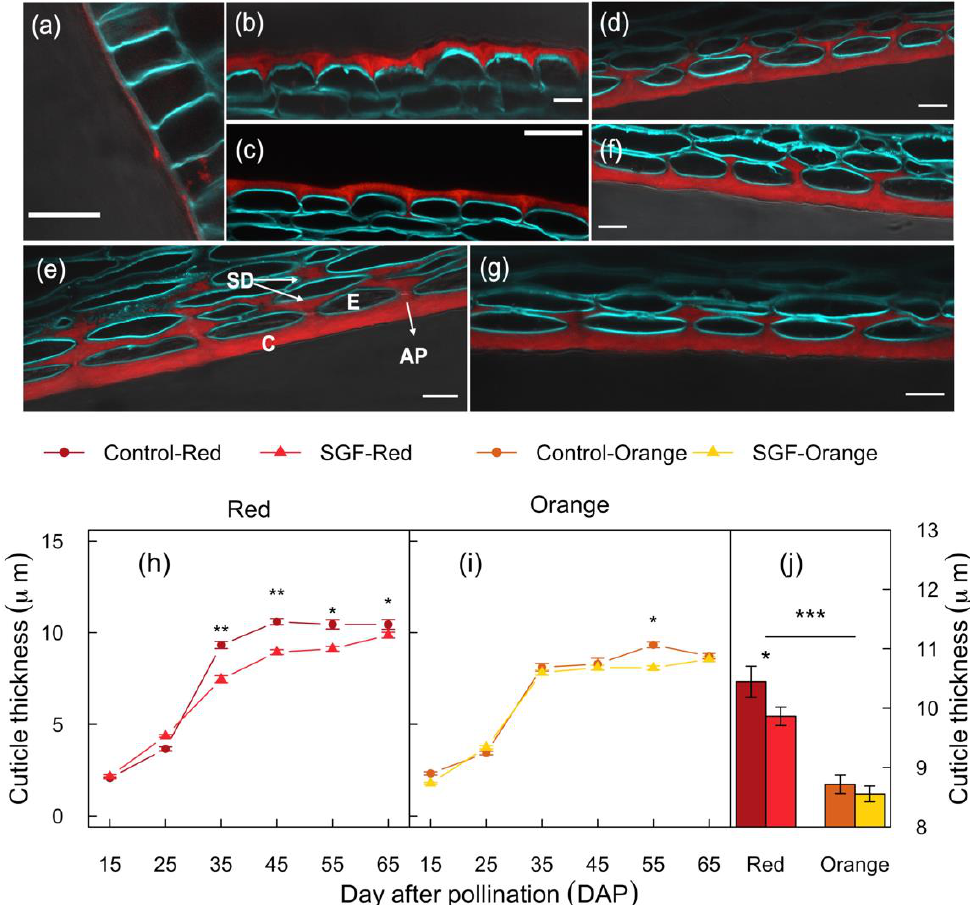
Figure 2. SGF impacts cuticle deposition during fruit development in a cultivar specific manner. ( a – g ) Confocal image panels showing the cuticle layer from the Red cultivar at 7 ( a ), 15 ( b ), 25 ( c ), 35 ( d ), 45 ( e ), 55 ( f ), and 65 ( g ) DAP. The lipophilic fluorescent dye Nile Red was used to stain the cuticle layer (red) and Calcofluor White M2R dye was used to stain cellulose in the cell walls (blue). Scale bar = 20 μm. ( h – i ) Cuticle thickness of fruits was quantified at different developmental stages using ImageJ. ( j ) The bar graph depicts the average cuticle thickness at the mature ripe stage (65 DAP) of Red and Orange cultivar development. Standard error bars are shown ( n = 12). Horizontal lines and stars denote statistical significance analyzed by one-way ANOVA (*: p ≤ 0.05, **: p ≤ 0.01, and ***: p ≤ 0.001). Abbreviations: Cuticle (C), epidermal cell (E), anticlinal peg (AP), sub-epidermal deposit (SD), Smart Glass Film (SGF), days after pollination